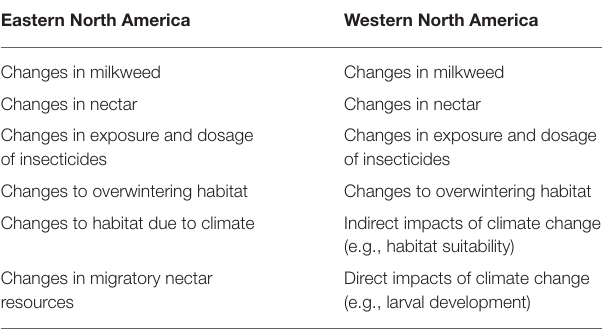
TABLE 2 | Primary drivers of population responses (threats and conservation